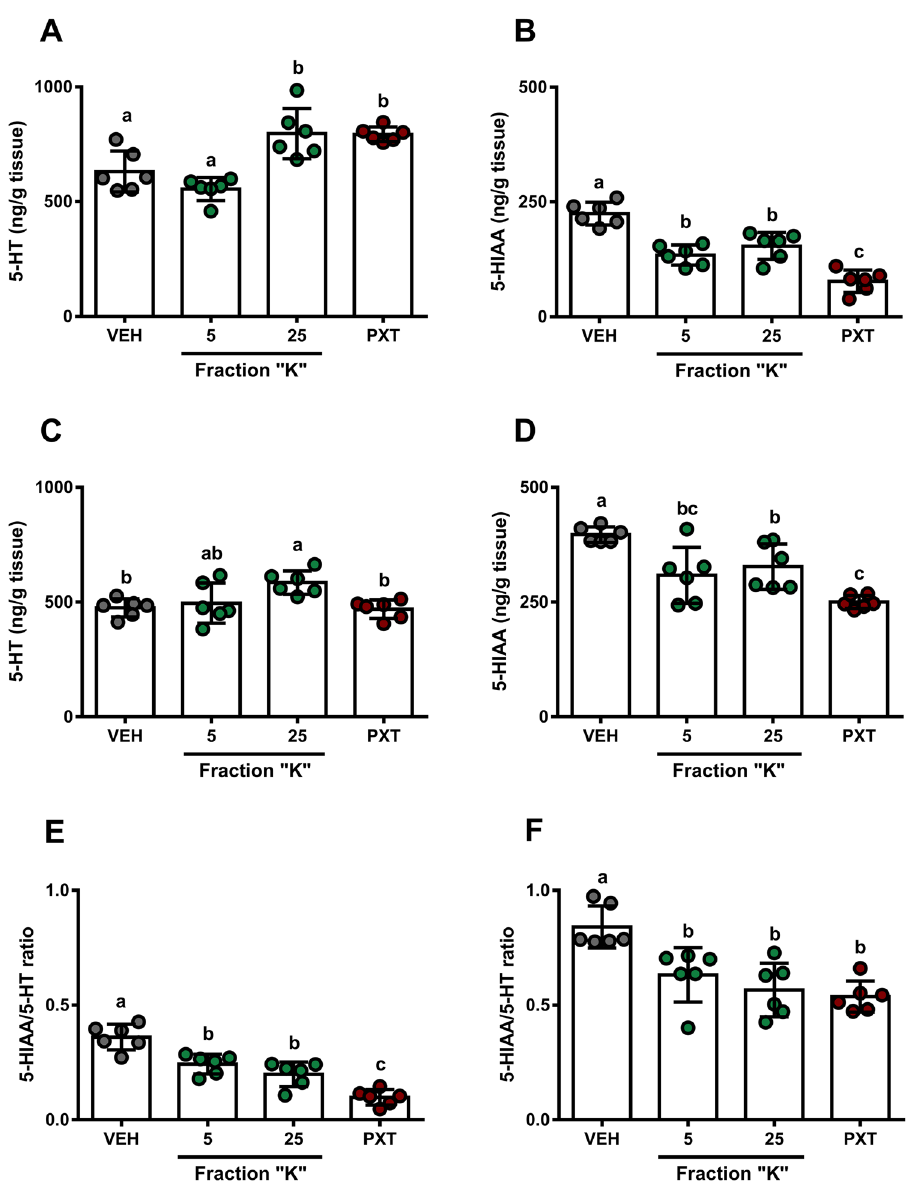
Figure 6. Regional brain tissue levels of 5-HT and 5-HIAA following fraction “K” and PXT treatments. ( A , B , E ) Prefrontal cortex. ( C , D , F ) Hippocampus. Mean (± SD; ng/g tissue) levels of prefrontal cortex ( A ) 5-HT, ( B ) 5-HIAA, and ( E ) 5-HIAA/5-HT ratios follow doses of fraction “K” (mg/kg dose indicated, all panels) or PXT (10 mg/kg, all panels). Mean (± SD; ng/g tissue) levels of hippocampus ( C ) 5-HT, ( D ) 5-HIAA, and ( F ) 5-HIAA/5-HT ratios follow doses of fraction “K” (mg/kg dose indicated, all panels) or PXT (10 mg/kg, all panels). One-way ANOVA followed by a Tukey’s HSD: p < 0.0001, all panels. Different letters indicate significant differences ( p <